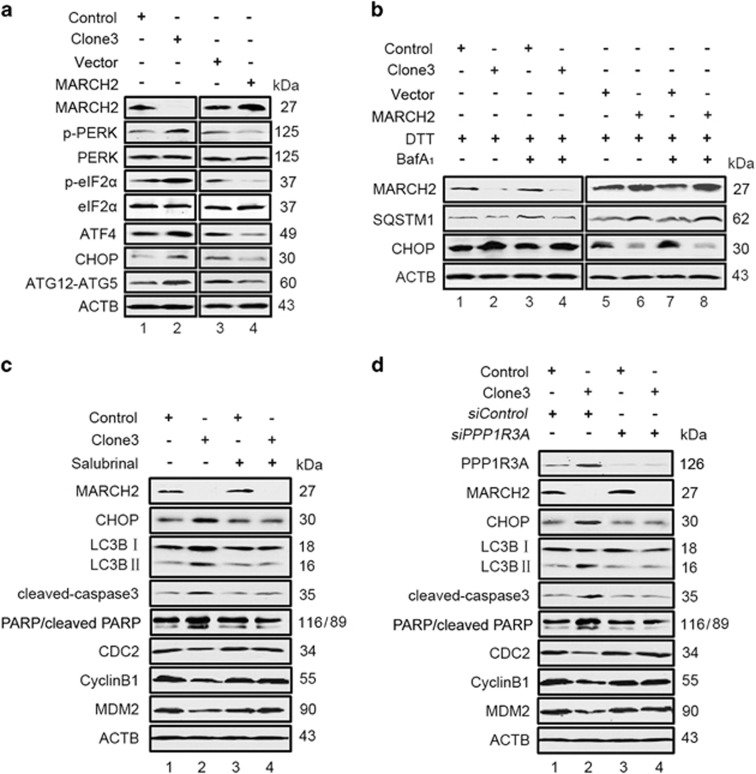
MARCH2 modulates ER stress. (a) Western blotting analysis of PERK, p-PERK (Thr 981) and p-EIF2α (Ser 51), EIF2α, ATF4, CHOP and ATG12-ATG5 levels in the indicated cell lines. ACTB was used as a loading control. (b) Control cells and Cas9-MARCH2 HCT116 cells were treated with BafA1 (10 nM) and/or DTT (1 mM) for 4 h and subjected western blotting to quantify CHOP and SQSTM1. (c) Control cells and Cas9-MARCH2 HCT116 cells were treated with or without salubrinal (5 μM) for 2 h and subjected western blotting to quantify CHOP, LC3B-II, cleaved caspase-3, cleaved-PARP, CDC2, Cyclin B1 and MDM2. (d) Cells were transfected with siRNA control or siRNA targeting PPP1R3A for 24 h, and subjected Western blotting to quantify endogenous CHOP, LC3B-II, cleaved caspase-3, cleaved-PARP, CDC2, Cyclin B1 and MDM2